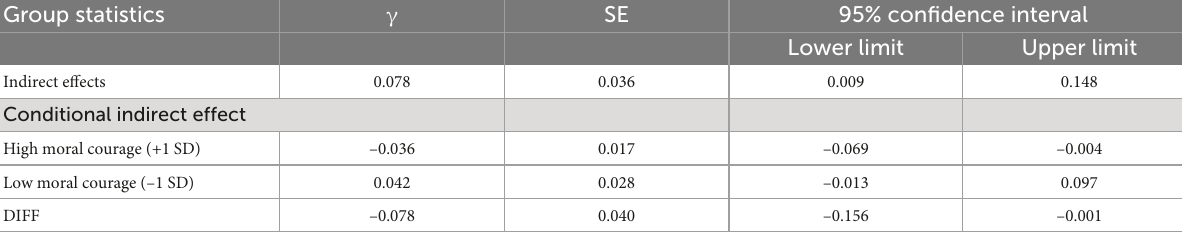
TABLE 6 The result of indirect effect and moderated